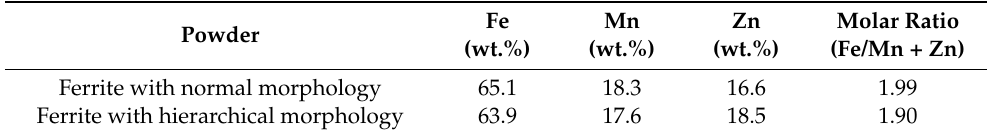
Figure 3. ( a – c ) SEM micrographs of synthesized MnZn ferrite with hierarchical morphology at different magnifications, and ( d ) corresponding EDS results. Table 1. ICP date for both synthesized ferrite powders.